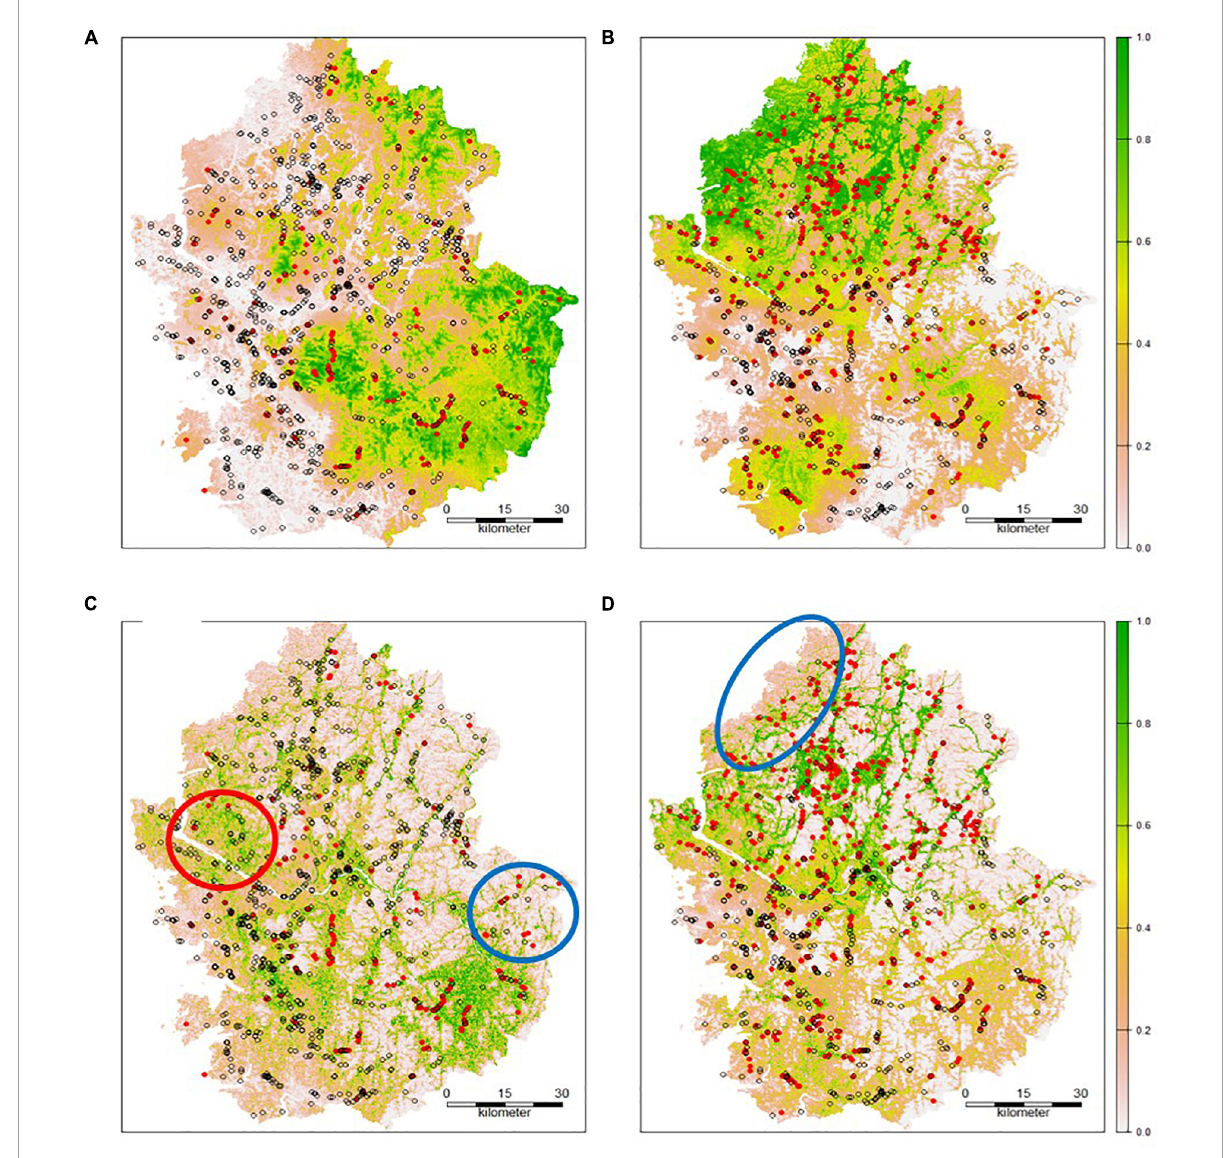
FIGURE3 Predicted probability using an regression kriging (RK) model ( A: Ambrosia artemisiifolia ; B: Ambrosia trifida ; red dot: presence; empty dot: absence; cross: test data point) and a Maxent model ( C: A. artemisiifolia ; D: A. Trifida ).